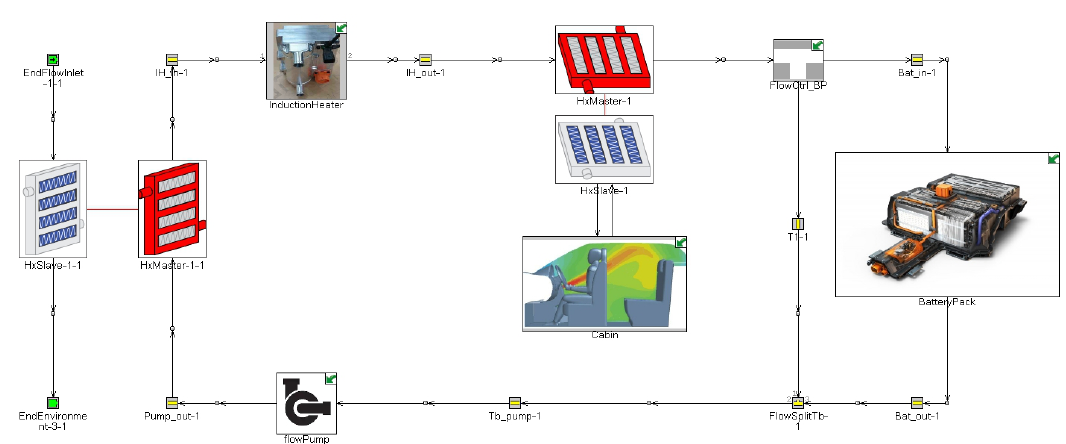
Figure 1. BTMS schematic diagram: series configuration.